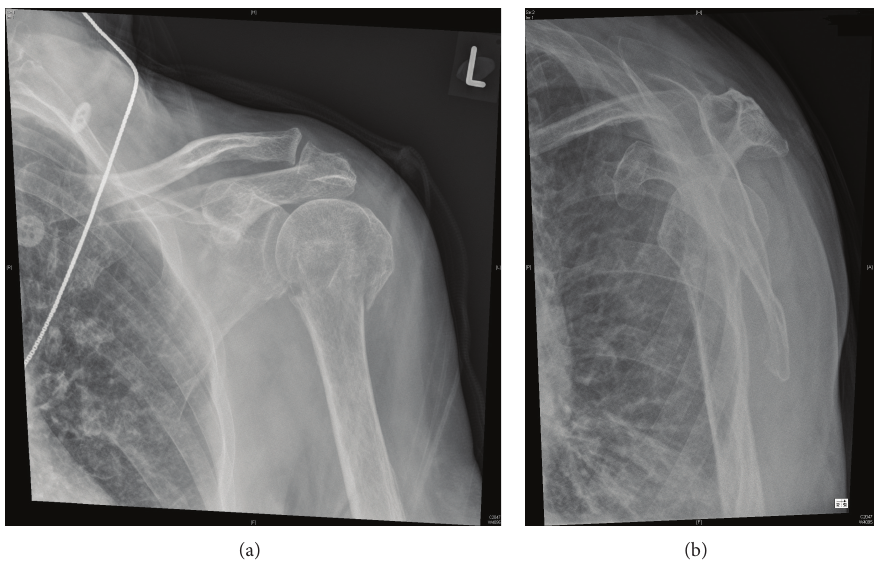
Figure 1: AP and lateral plain film radiographs demonstrating a proximal humerus fracture.